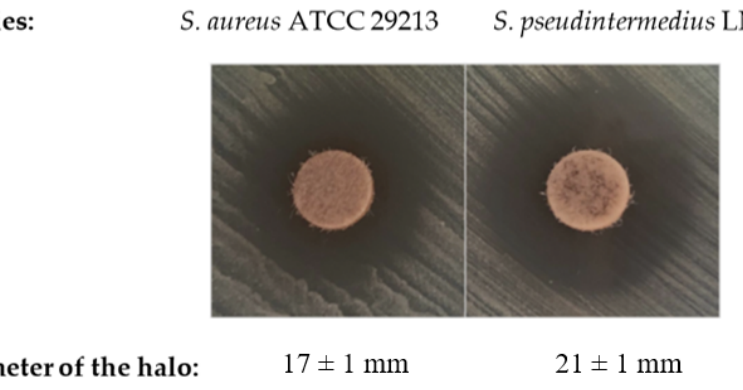
Figure 1. Semi-quantitative analysis of the inhibitory effect of DHAB on the growth of Staphylococcus spp. Using the disks test. Data are mean ± standard deviation of three determinations.